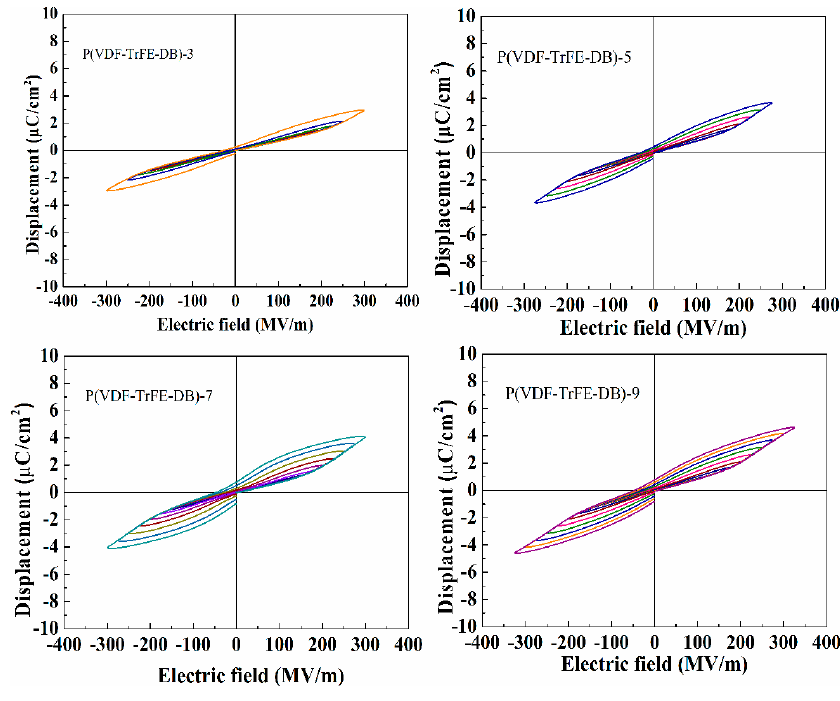
Figure 8. D–E loops of P(VDF-TrFE-DB)s films from solution cast at 50 °C.